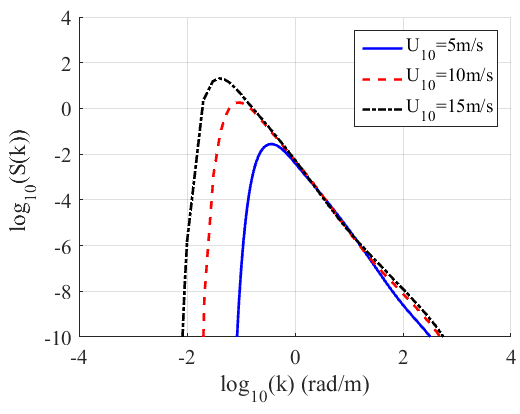
Figure 3. The sea spectrum for various wind speeds.